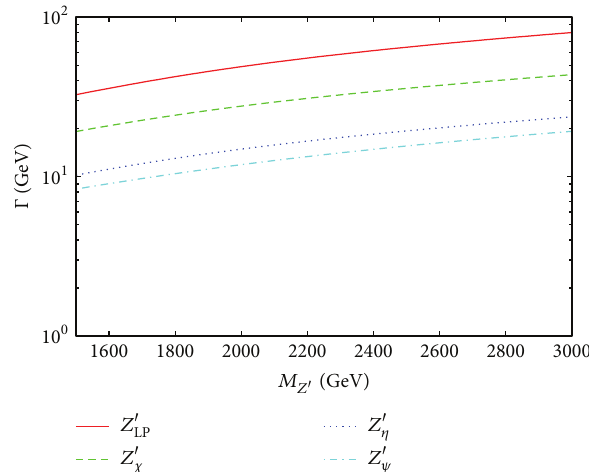
Figure 1: The decay widths of 𝑍 󸀠 boson depending on its mass for different 𝑍 󸀠 models with the FCNC parameter 𝑥 = 0.1 . Here, we use the mass value of new heavy quarks as 700 GeV and the mass value of new heavy charged lepton and neutrino as 200 GeV and 100GeV, respectively.